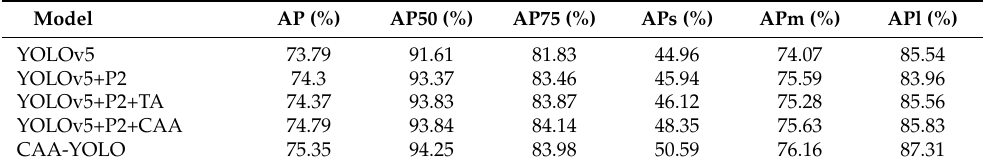
Table 6. Average precision of experimental results when IoU = 0.6 and confidence =